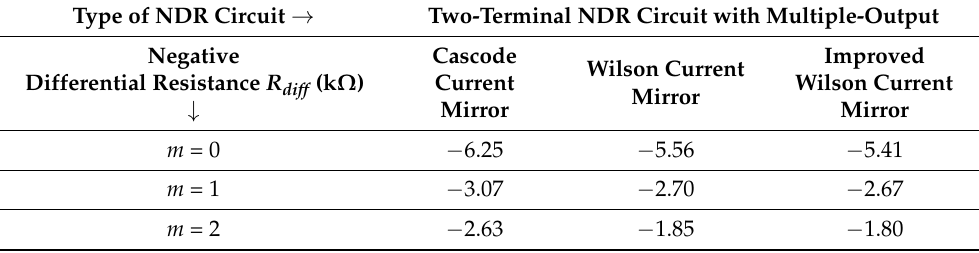
Table 7. Simulated negative differential resistance for different two-terminal NDR circuits ( T 0 —PHEMT). Type of NDR Circuit